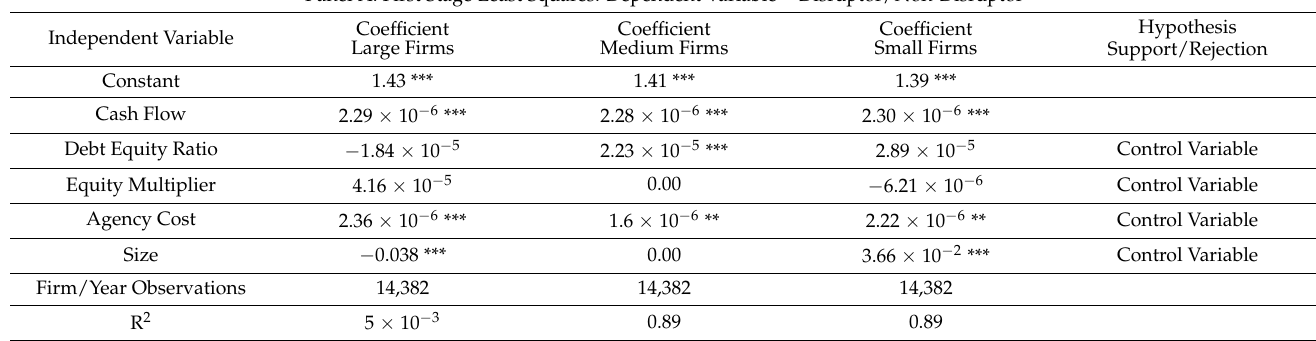
Table 7. Effect of Varying Asset Sizes. Two-Stage Least Squares Regressions of Cash Flow on Disruption, Followed by Disruption on Financial Performance. Panel A: First Stage Least Squares: Dependent Variable =